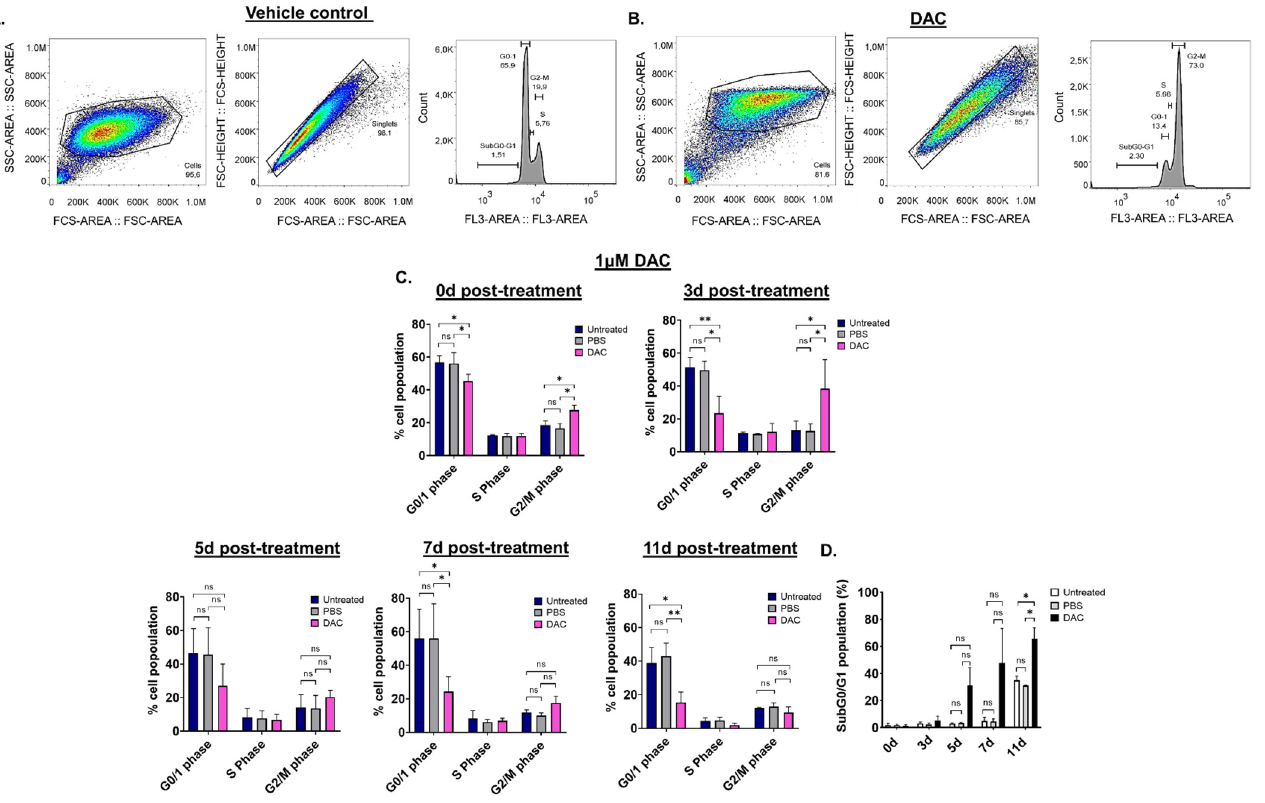
Figure 2. DAC treatment induces changes in cell cycle distribution in HeLa cells. Cell cycle analysis was performed to determine potential changes in the cell cycle of HeLa cells in response to DAC treatment (1 μΜ , 72 h) using flow cytometry. The appropriate gating was conducted to select the desired cell population for the analysis, as shown by the raw data presented at 3d post-treatment for the PBS-treated cells (vehicle control) ( A ) and the DAC-treated cells ( B ). ( C ) The graphs show the mean percentage of cell population for each of the cell-cycle phases (G0/1 phase, S phase, G2/M phase) in response to DAC treatment at 1 μΜ , 72 h at the indicated time points (0d, 3d, 5d, 7d, 11d). ( D ) The percentage of the mean population at the SubG0/G1 was plotted for each of the time-points post-treatment (0d, 3d, 5d, 7d, 11d post-treatment) in response to 1 μΜ DAC treatment (72 h). The data represent average values from three independent experiments. The data are plotted as the mean ± SD. Statistical analysis was performed using two-way ANOVA with Tukey’s multiple com- parisons test (* p < 0.05, ** p < 0.01, ns = not statistically significant). Our data showed that the two lowest cisplatin doses (0.156 μΜ , 0.3125 μΜ ) resulted in a significant reduction in cell viability by 1.1- and 1.4-fold, respectively, in HeLa cells compared to the untreated cells (* p < 0.05) (Figure S4A), but did not cause any significant reduction in cell viability in CaSki cells (Figure S4B). Similarly, low doses of cisplatin (0.156 μ M, 0.3125 μΜ , 0.625 μΜ ) did not cause any drop in cell viability in the case of C33A cells compared to the untreated cells (Figure S4C). Significant reduction in cell via- bility of C33A cells was noted in response to the higher doses of cisplatin (1.25 μΜ , 2.5 μΜ , 5 μΜ , 10 μΜ , 20 μΜ ). Overall, cell viability followed a dose-dependent reduction in response to the low and high doses of cisplatin in all CC cell lines tested. The greatest reduction in cell viability was observed at 20 μΜ resulting in 411-fold reduction in C33A, 134-fold in CaSki, and 93-fold in HeLa cells (Figure S4A–C).